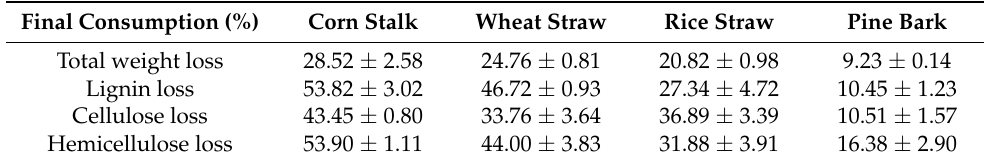
Table 4. Final consumption of C. unicolor SP02 on different substrates. Final Consumption (%)